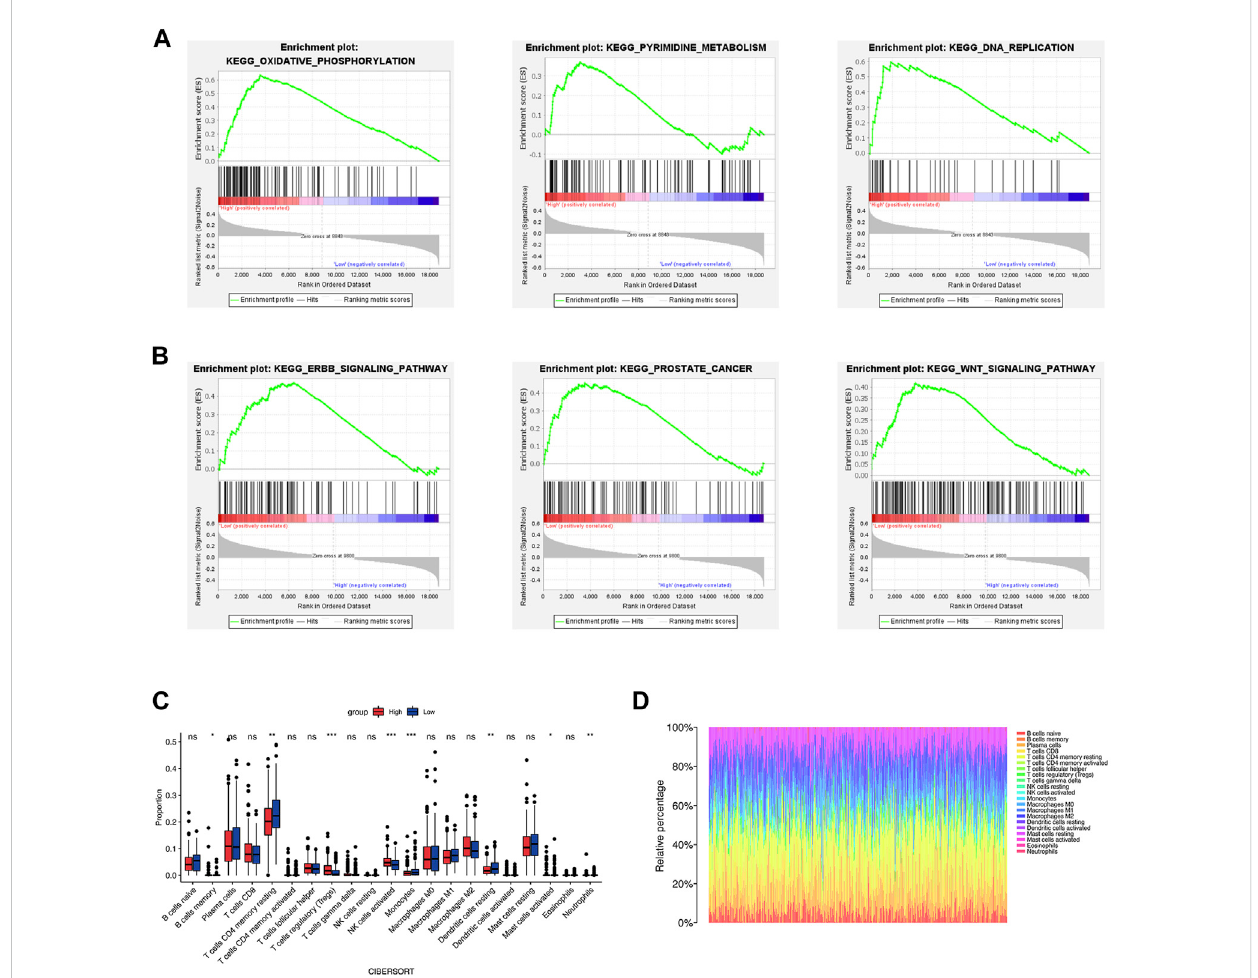
FIGURE 7 Functional enrichment analysis and immune cell in fi ltration. (A, B) The results of GSEA analysis of the high- and low-risk groups. (C, D) The immune cell in fi ltration by CIBERSORT algorithm. * p < 0.05; ** p < 0.01; *** p < 0.001; ns, no signi fi cance.